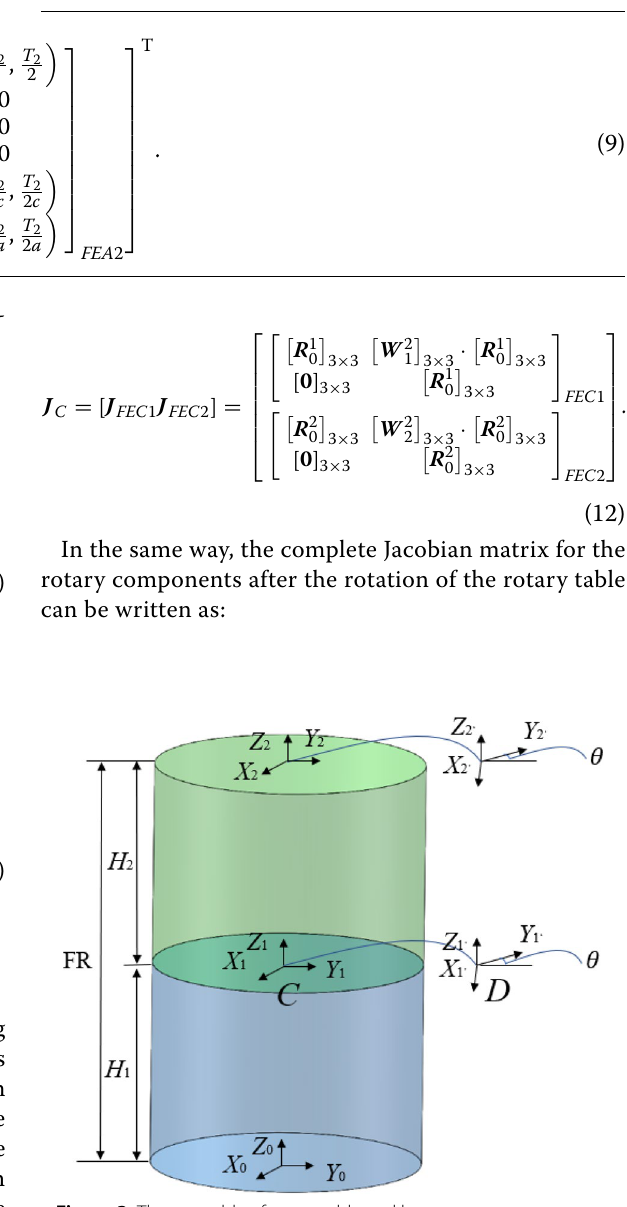
Figure 3 The assembly of rotary table and